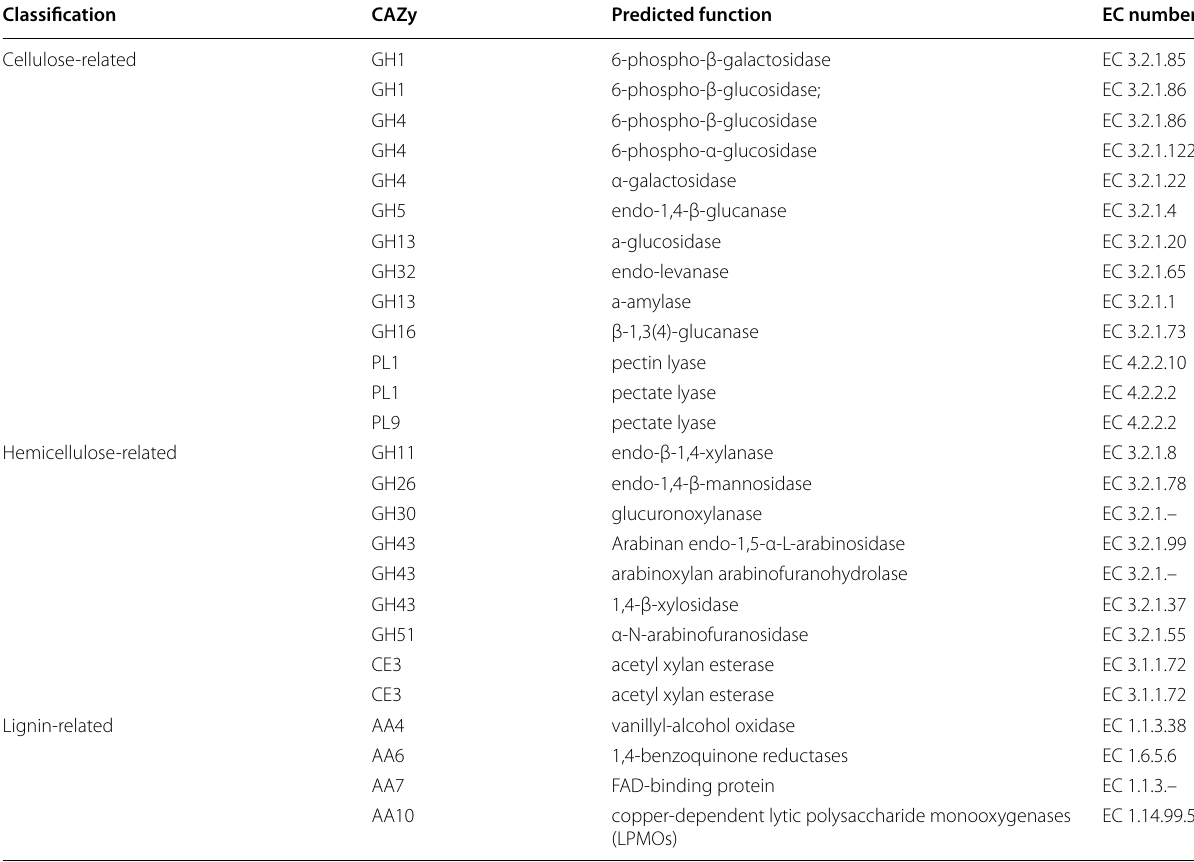
Table 1 Annotated common genes encoding lignocellulose-degrading enzymes in the twenty-three B. velezensis strains